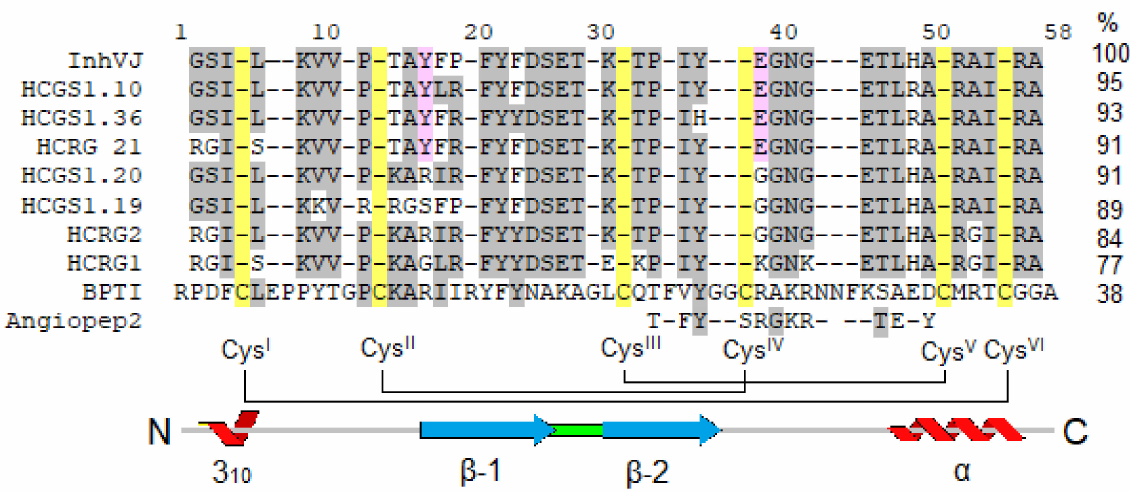
Figure 8. Multiple alignment of sea anemones Kunitz-type peptides using in research and BPTI from Bos taurus and Angiopep2 derived from it. Identical residues are shown by dashes, conservative residues are shown on light grey color, residues distinguishing active peptides are shown on pink, Cys are shown on yellow. Secondary structure elements and disulfide bond diagram are displayed according to BPTI